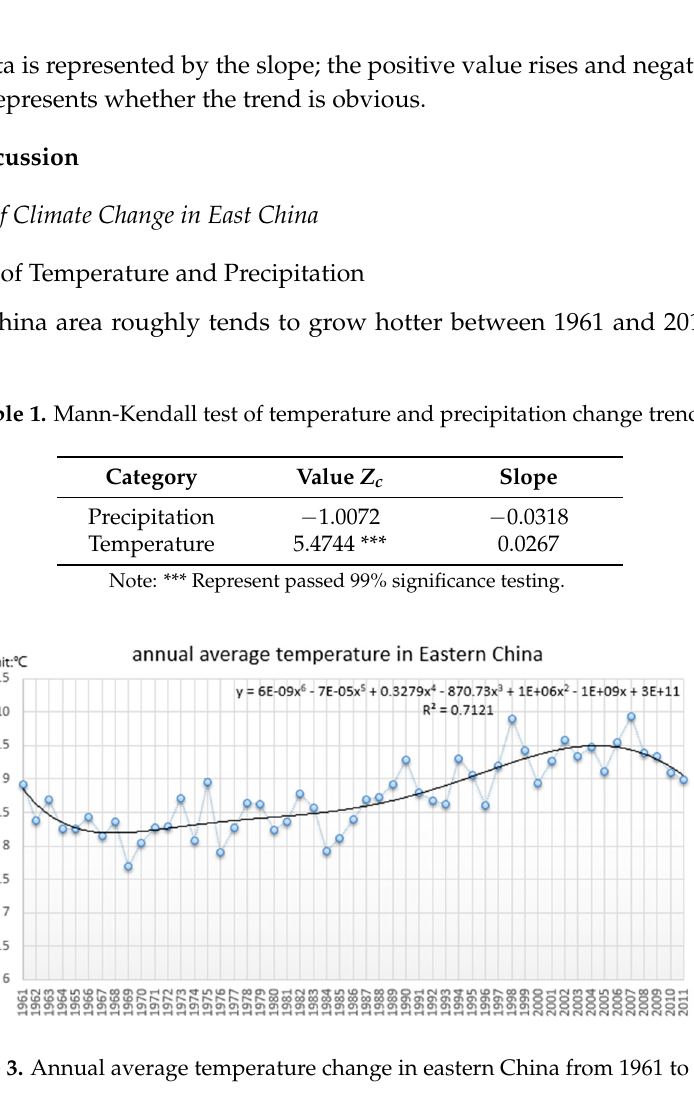
Table 1. Mann-Kendall test of temperature and precipitation change trends Category Value Z c Slope Precipitation − 1.0072 − 0.0318 Temperature 5.4744 *** 0.0267